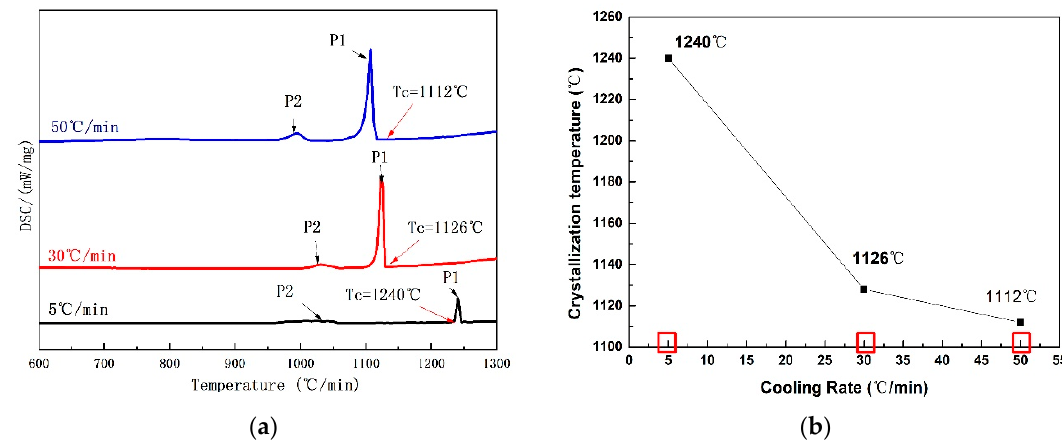
Figure 8. ( a ) DSC curves of non-isothermal crystallization of the CaO–Al 2 O 3 -based mold flux at the cooling rates of 5 °C·min − 1 , 30 °C·min − 1 , and 50 °C·min − 1 . ( b ) The crystallization temperatures at the cooling rates of 5 °C·min − 1 , 30 °C·min − 1 , and 50 °C·min − 1 .